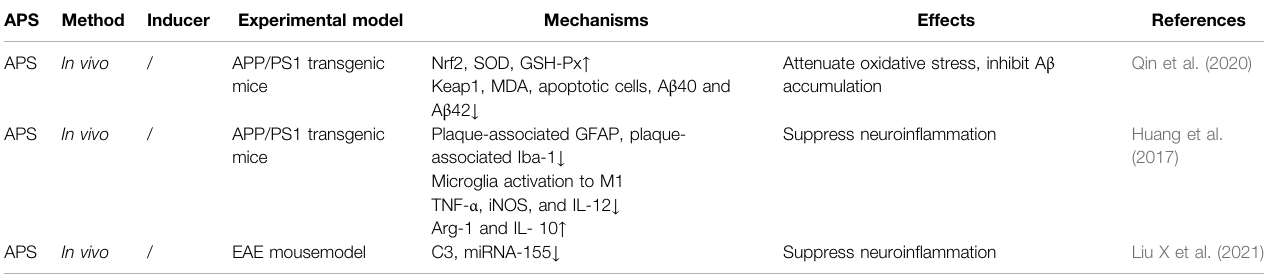
TABLE 3 | The effect and mechanisms of polysaccharides from Astragali radix against AD. APS Method